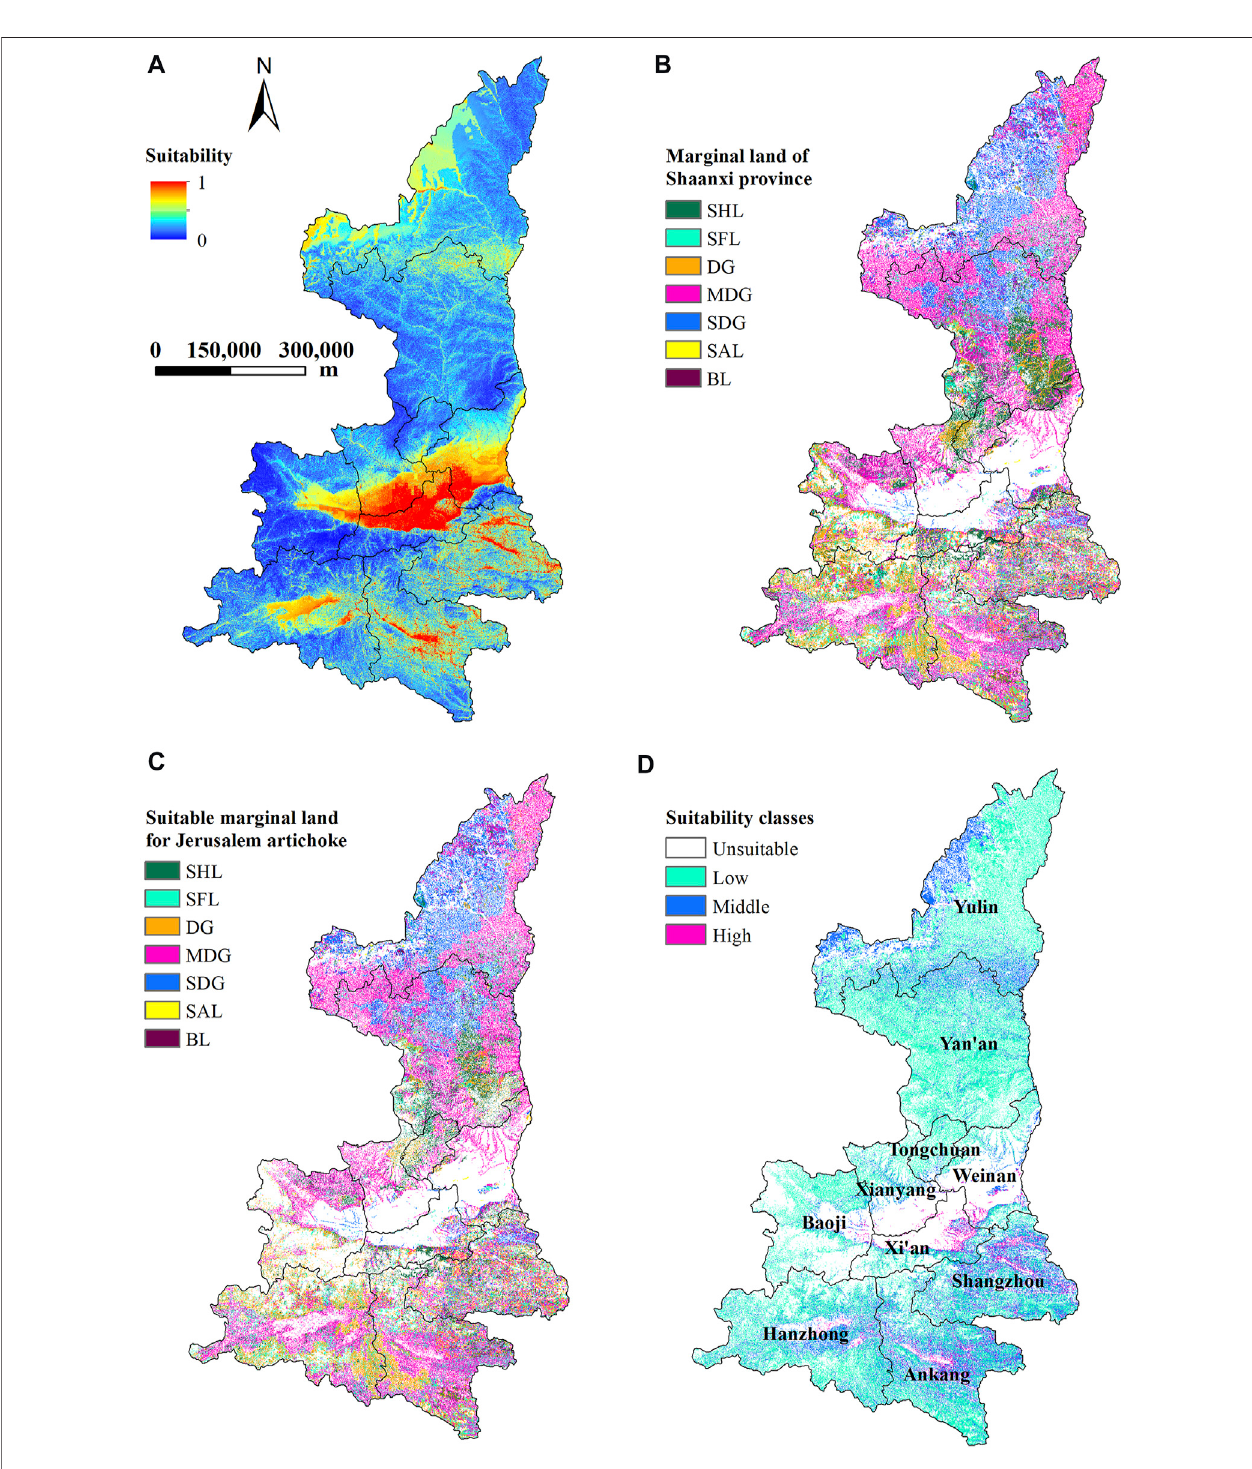
FIGURE 4 | The area suitable for planting Jerusalem artichoke in Shaanxi Province: (A) spatial distribution of the pre-diction of the Maxent model (different colors indicate the prediction probability of different suitable conditions, and the red color (the value close to 1) means more suitable for planting, and the blue color (the value close to0)meanslesssuitableforplanting ofJerusalemartichoke); (B) spatialdistribution ofmarginallandofShaanxiProvince(SHL:shrubland,SFL:sparseforest land, DG: dense grassland, MDG: moderate dense grassland, SDG: sparse dense grassland, SAL: saline land, BL: bare land); (C) spatial distribution of marginal land suitableforJerusalemartichokeinShaanxiProvince; (D) spatialdistributionofclassi fi cation resultsofmarginal landsuitableforJerusalem artichokeinShaanxiProvince.